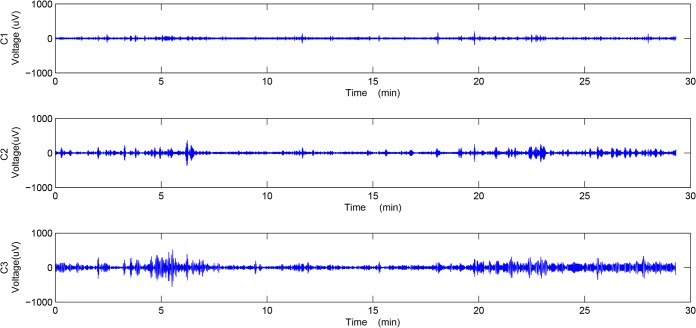
Empirical mode decomposition of a preterm delivery record.The top (C1), middle (C2) and bottom (C3) plots show the first three components of the IMFs obtained by EMD.